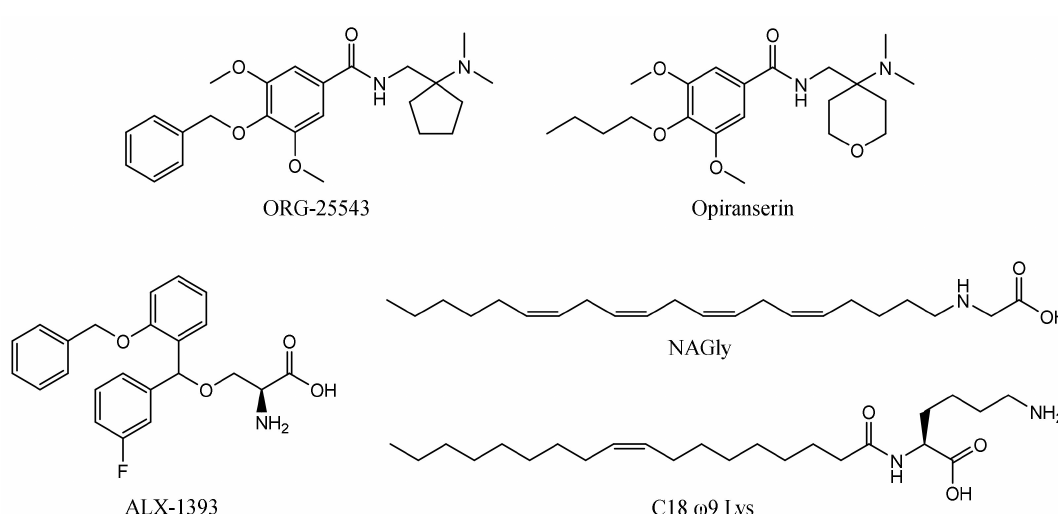
Figure 2. Examples of selective GlyT-2